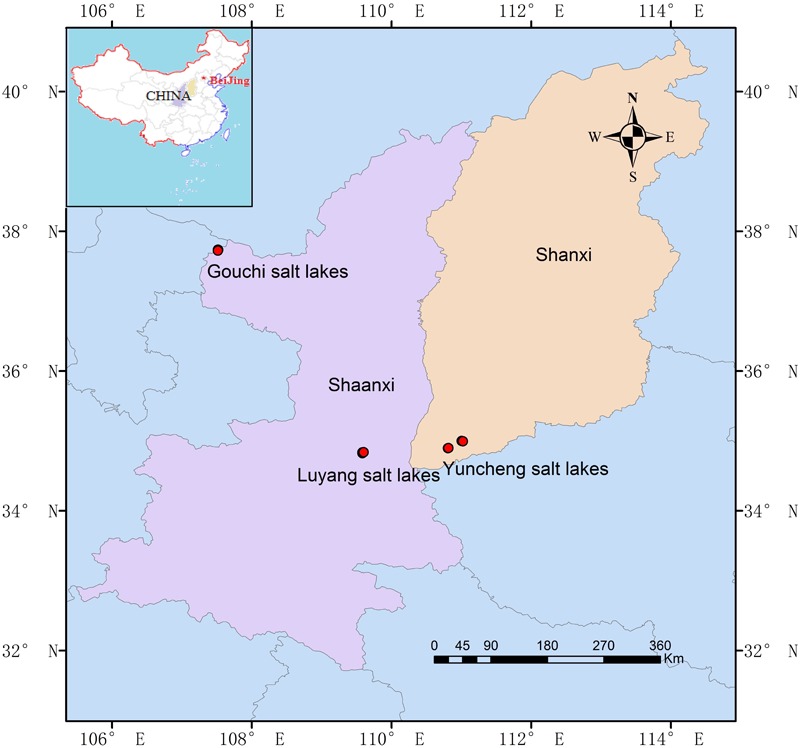
Geographic location of the Gouchi salt lake, Yuncheng salt lake, and Luyang salt lake. Location map of the sampling sites was created using ArcGIS software by Esri.